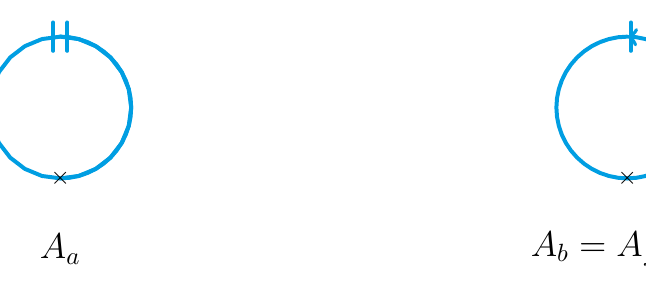
Figure 31. PV one loop A type integrals in the average-di(cid:11)erence